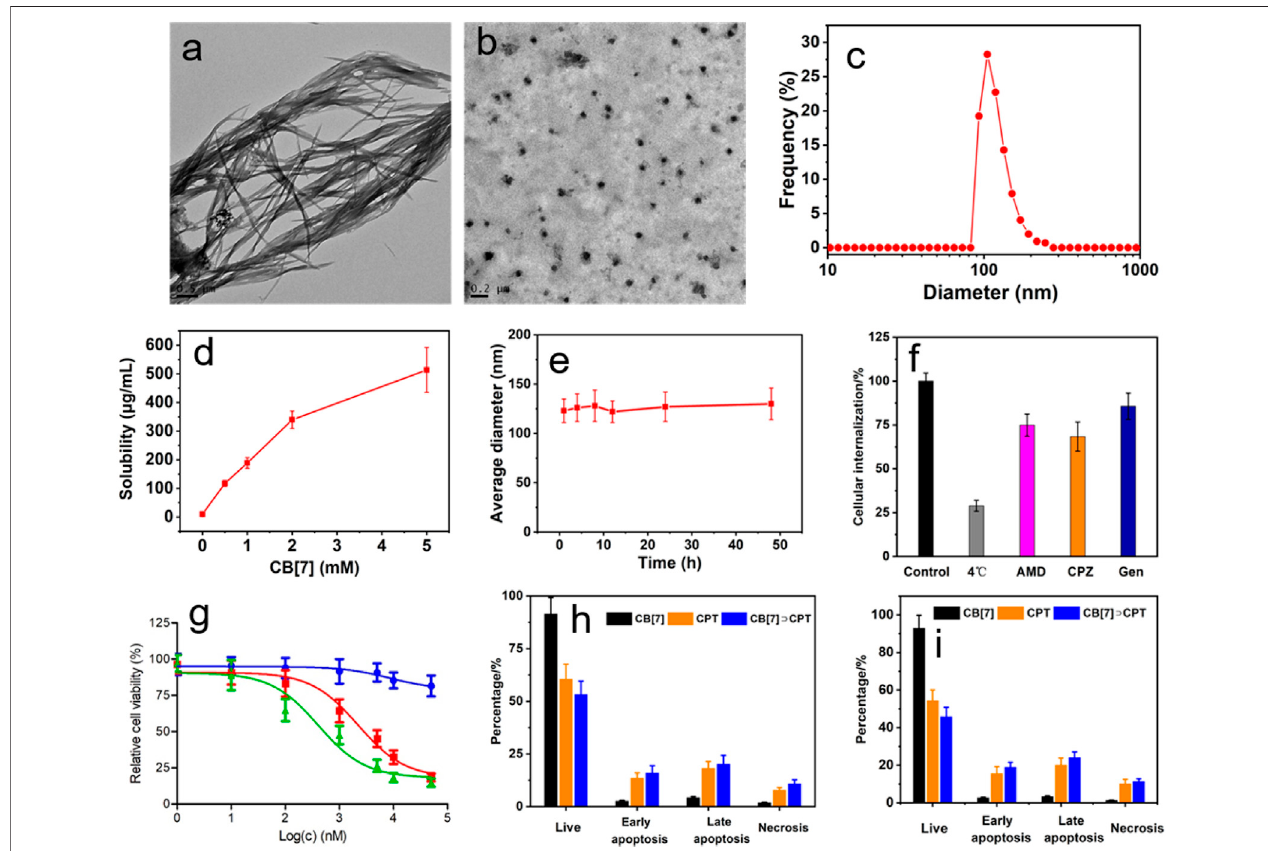
FIGURE 4 | TEM images of aggregates formed from CPT (A) and spherical nanoparticles formed from CB[7] ⊃ CPT (B) , (C) DLS size distributions of nanoparticles self-assembled from CB[7] ⊃ CPT, (D) solubility improvement of CPT after the addition of different quantities of CB[7], (E) average diameter change of CB[7] ⊃ CPT after incubationinPBSfordifferenttimes, (F) internalizationef fi ciencyanalysisofCB[7] ⊃ CPTafterincubationwithdifferentendocytosisinhibitors, (G) cytotoxicityagainstU87 cells incubated with different concentrations of CB[7] ⊃ CPT for 24 h (blue: CB[7]; red: CPT; green: CB[7] ⊃ CPT), and fl ow cytometric analysis of Annexin-V/PI dual- staining of U87 cells (H) and HeLa cells (I) after different